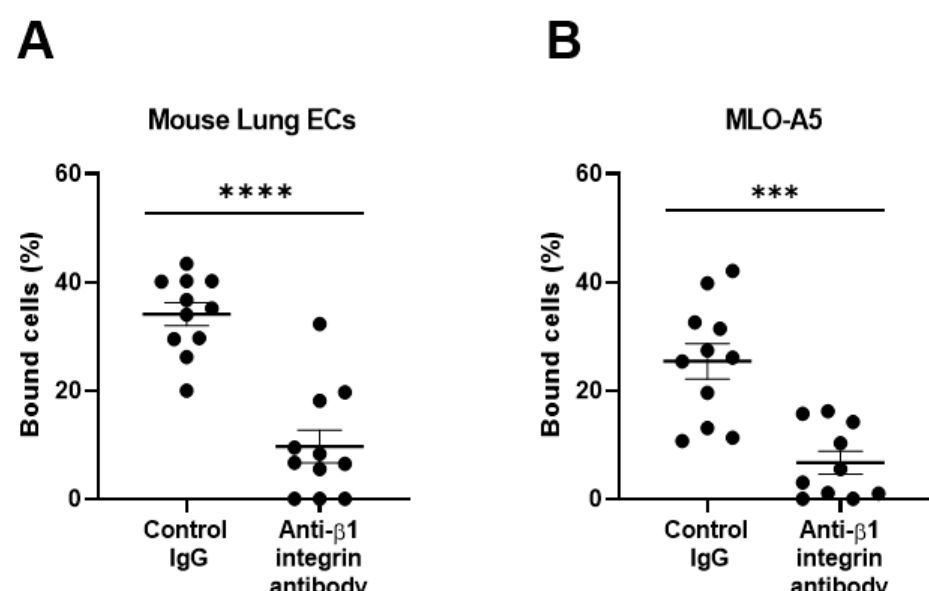
Figure 2. Expression of β 1, α V, and α 4 integrins on cells. The cells were stained with the fluorescently labeled monoclonal antibodies (mAbs) to integrins. The integrin expression was analyzed by using flow cytometry for human ( A ) and mouse ( B ) cells. Histograms indicate the expression of integrins indicated. Data are representative of three separate experiments. Red lines, mAb; black lines, isotype IgG.